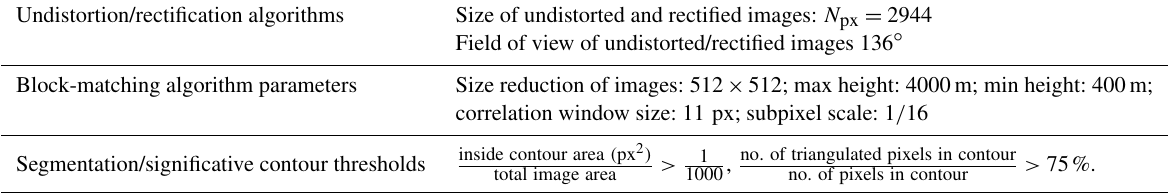
Segmentation/significative contour